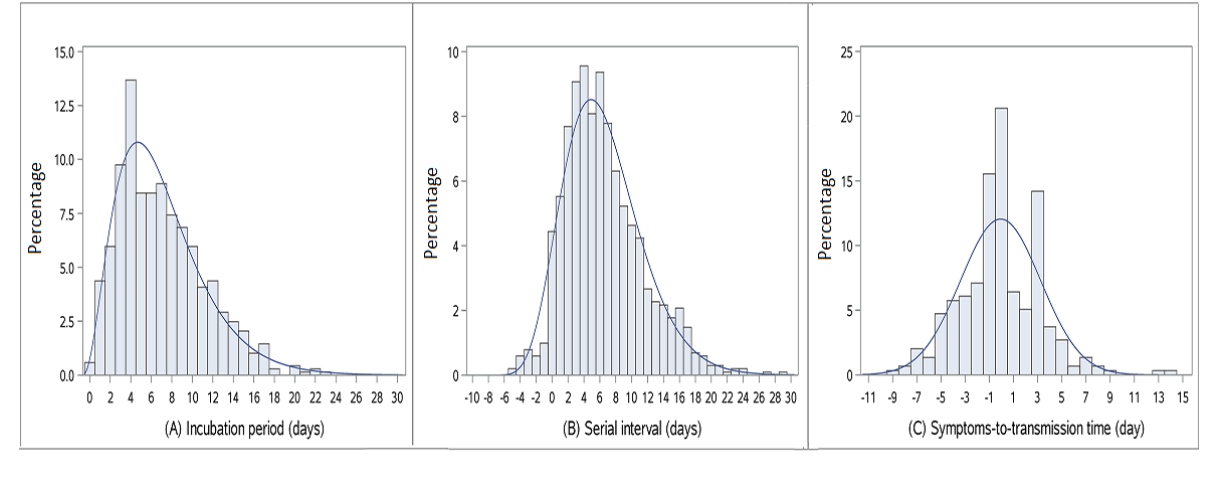
Figure 2. The distribution of (A) incubation period (n=687), (B) serial interval (n=1015 pairs), and (C) symptoms-to-transmission time (n=296